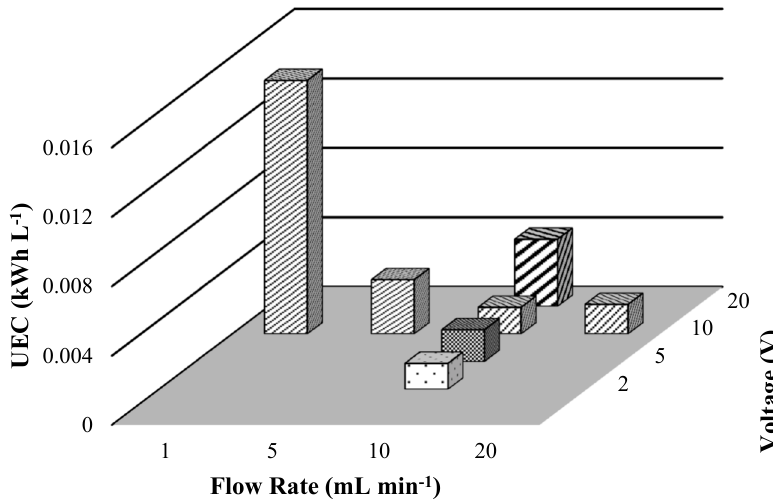
Figure 4. Unit energy consumption (UEC) of REM under different operation conditions with 4 ACFC layers.